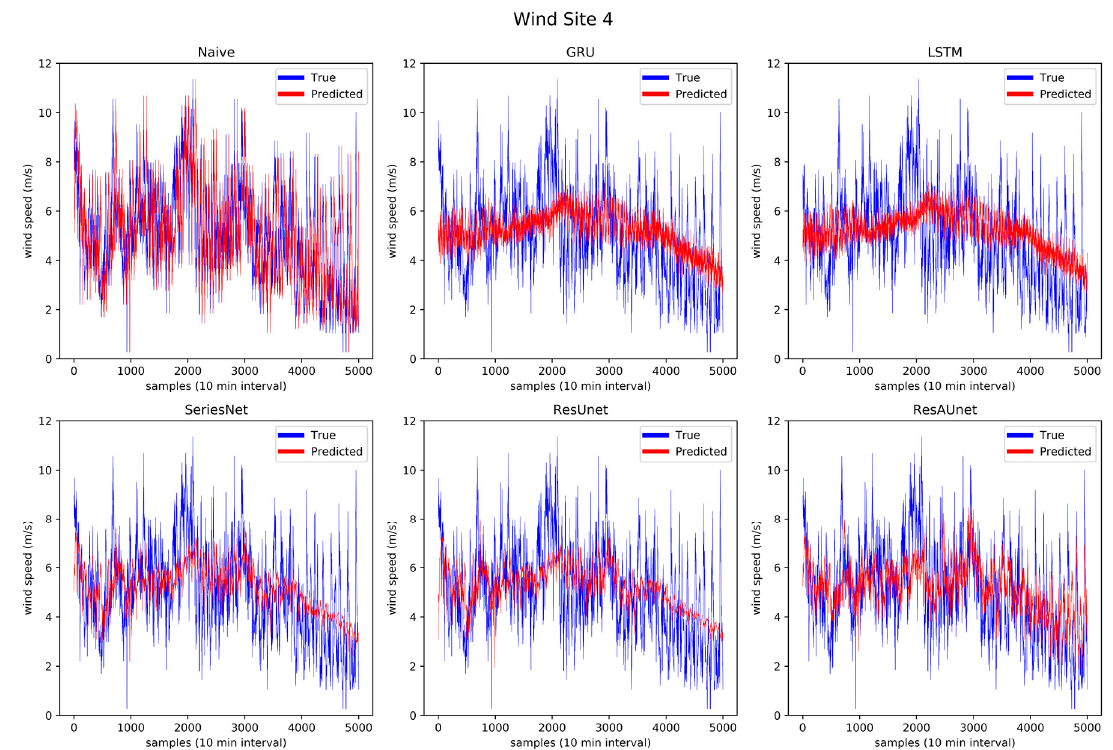
Figure 16. Prediction results of the six models for wind Site 4.